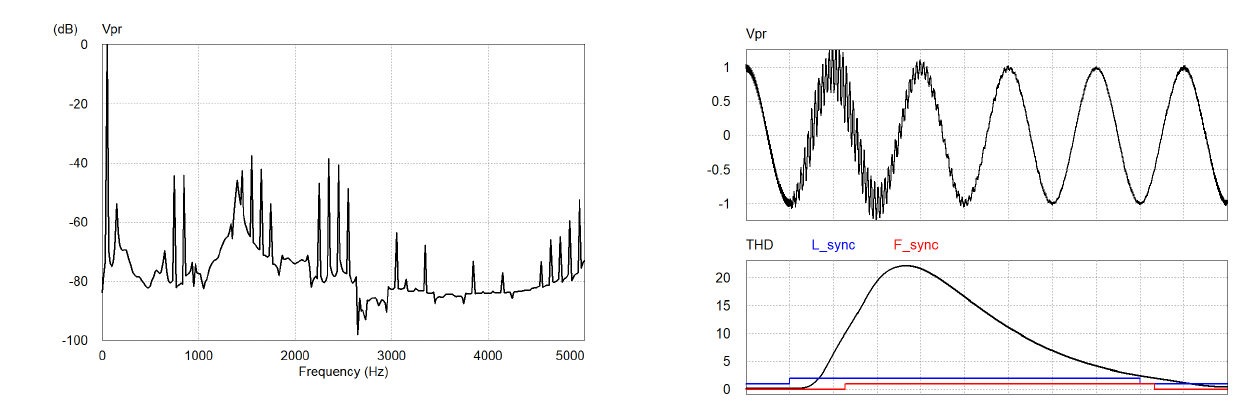
Figure 23. Frequency spectrum of the primary voltage (Vpr) with different switching conditions.